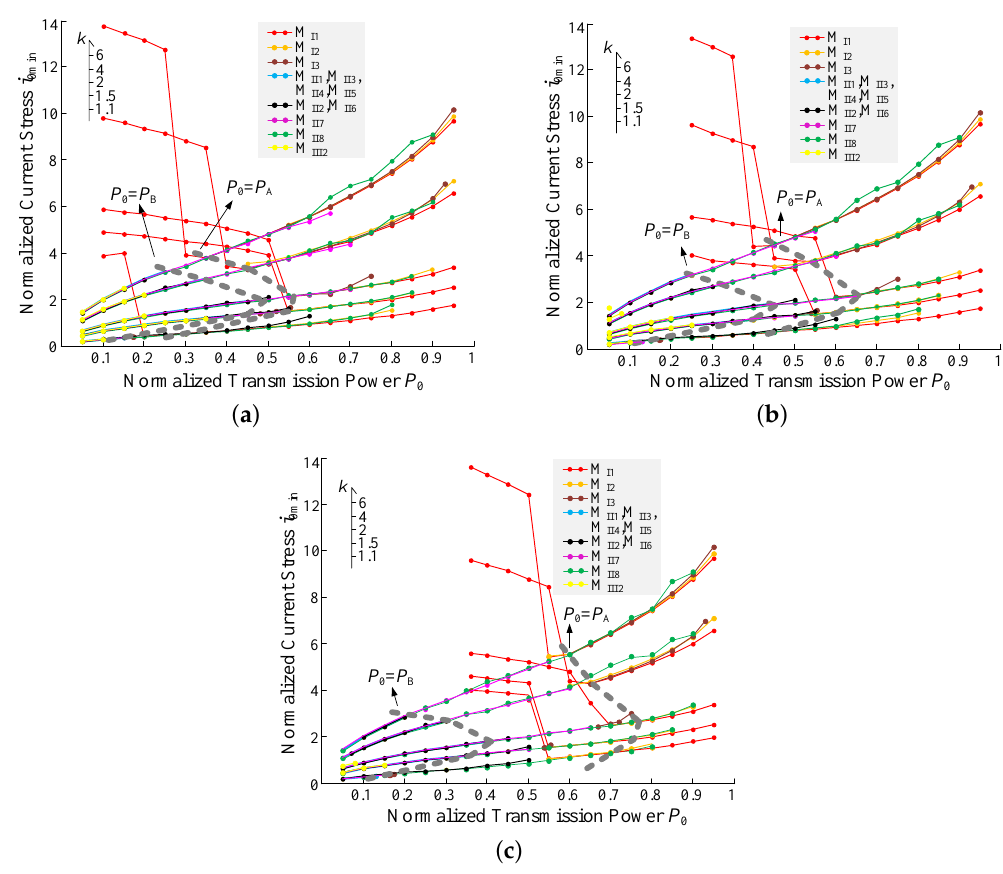
Figure 12. Curves of the minimum current stress in each sub modes: ( a ) M min = 0.02; ( b ) M min = 0.05; and ( c ) M min = 0.1. Table 3. Optimization Algorithm of TPS incorporating dead time (TPSiDT) Scheme. Range of P